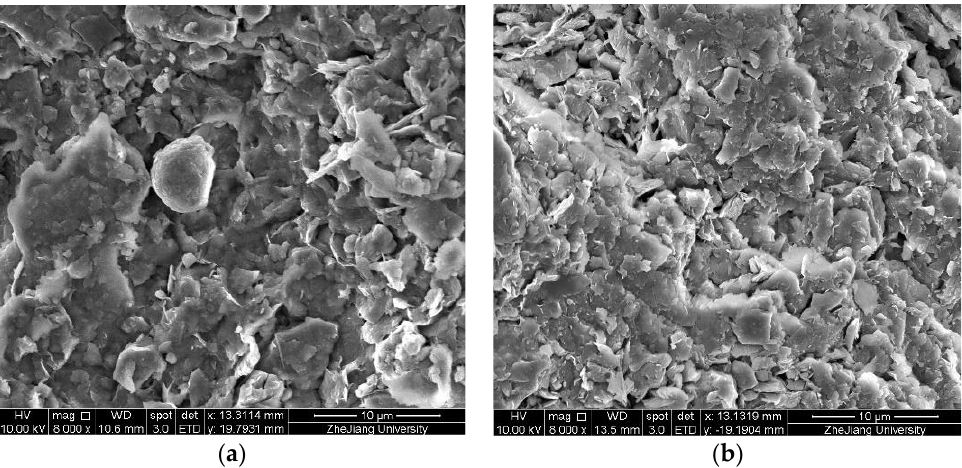
Figure 2. Scanning electron microscope (SEM) images of soft clay: ( a ) unfrozen soil; ( b ) frozen- thawed soil.